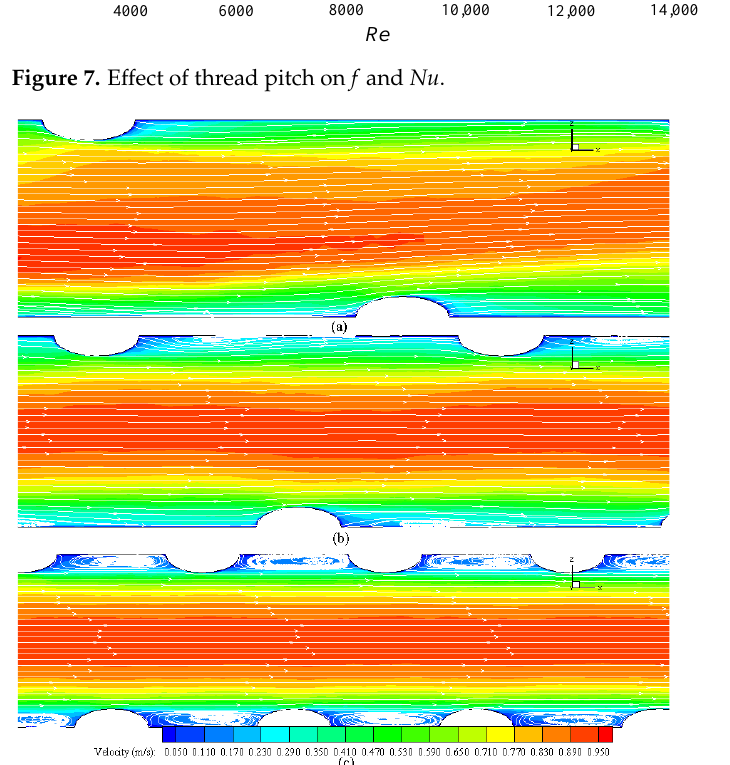
Figure 8. Streamtraces and velocity profile contours inside SCPs: ( a ) for pipe 3#, ( b ) for pipe 2#, ( c ) for pipe 1#.